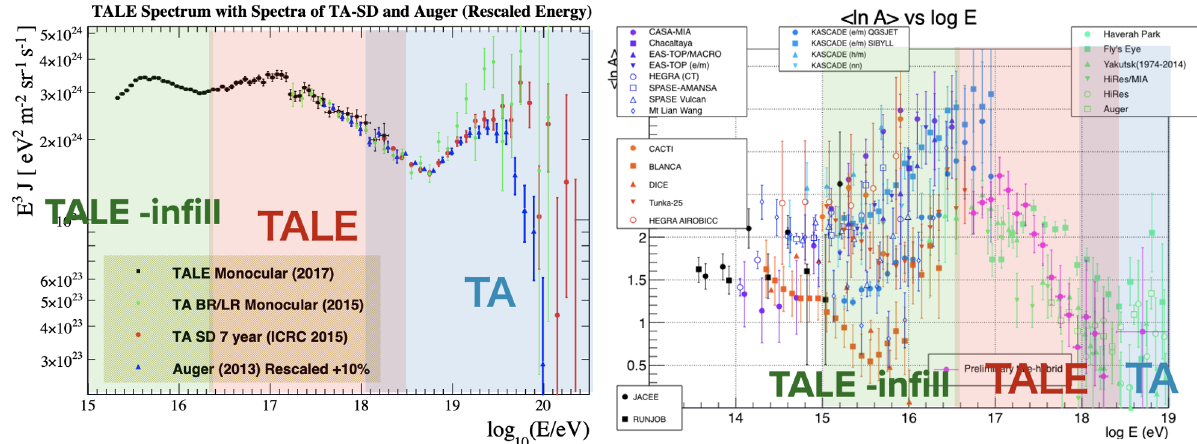
Figure 1: Energy spectrum (left) and composition (right) from the knee region onwards. Measurements of (cid:104) X max (cid:105) with di-